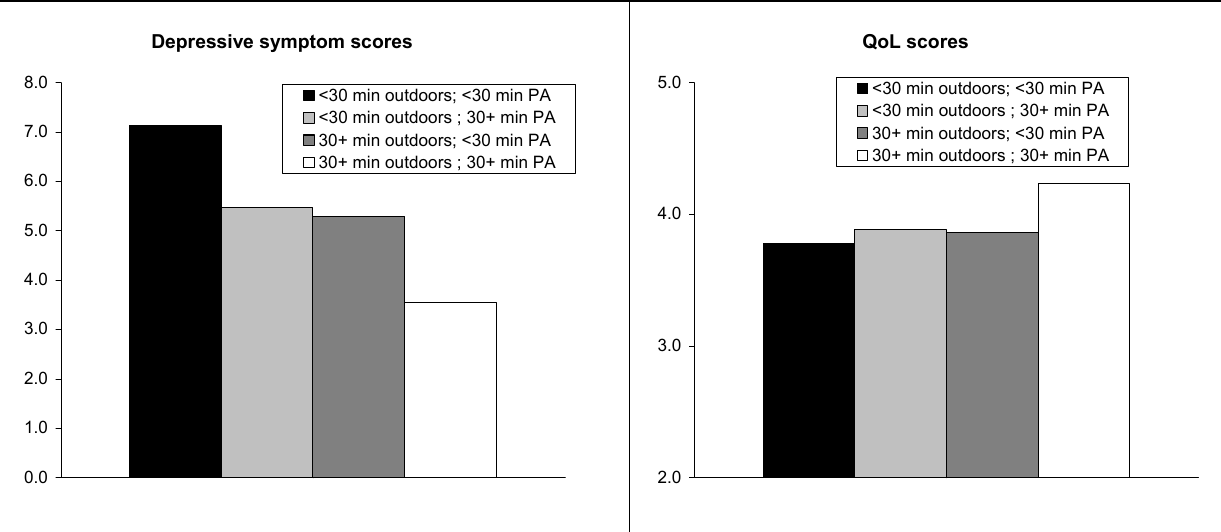
Figure 1. Mean scores for the four groups tested in the PA by outdoor time interaction. Depressive symptom